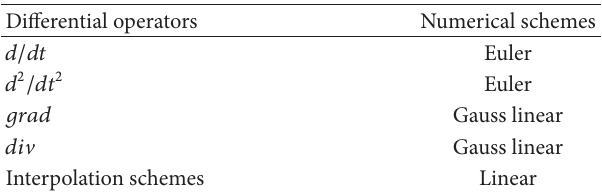
Table 1: Numerical schemes used for discretizing the wave equation and the boundary conditions.